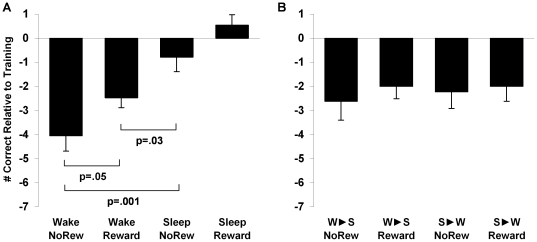
Performance data for all groups.A. 12 hr groups. B. 24 hr groups. (means±SEMs).